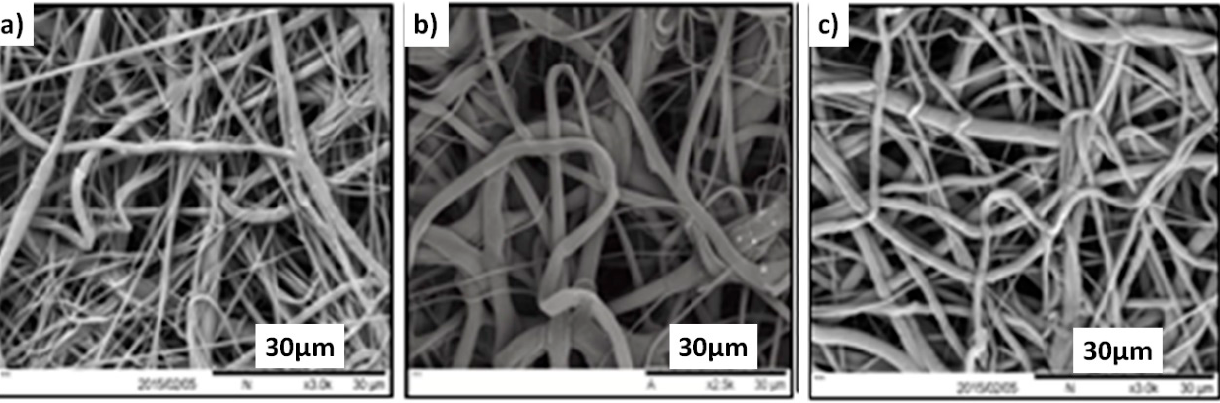
Figure 5. Scanning electron microscope (SEM) micrographs of the surface morphology of the electrospun scaffolds: ( a ) sample 1, ( b ) sample 2, ( c ) sample 3.